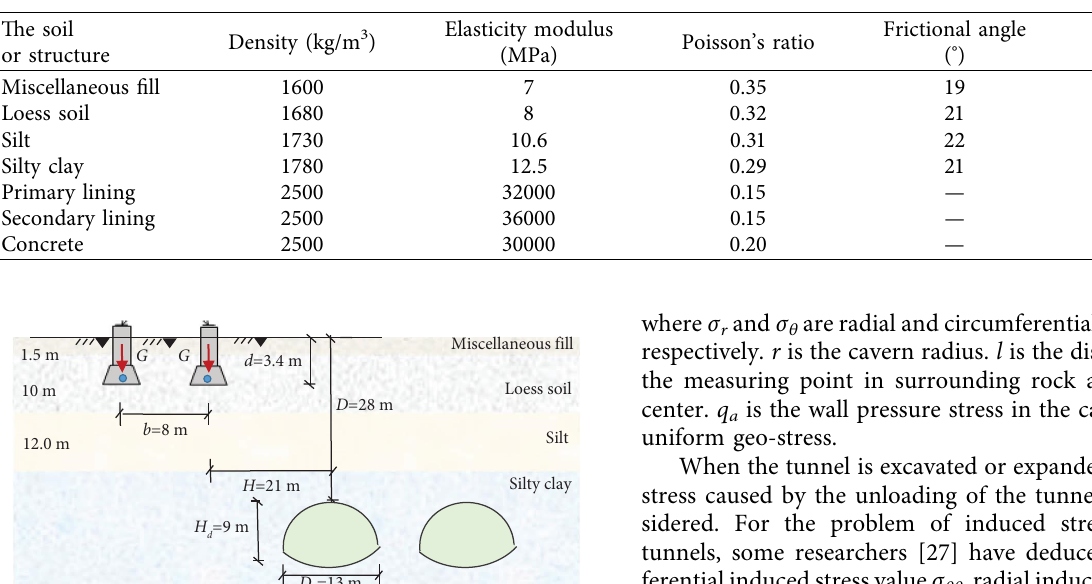
Table 1: Material parameters of soil and lining structure.